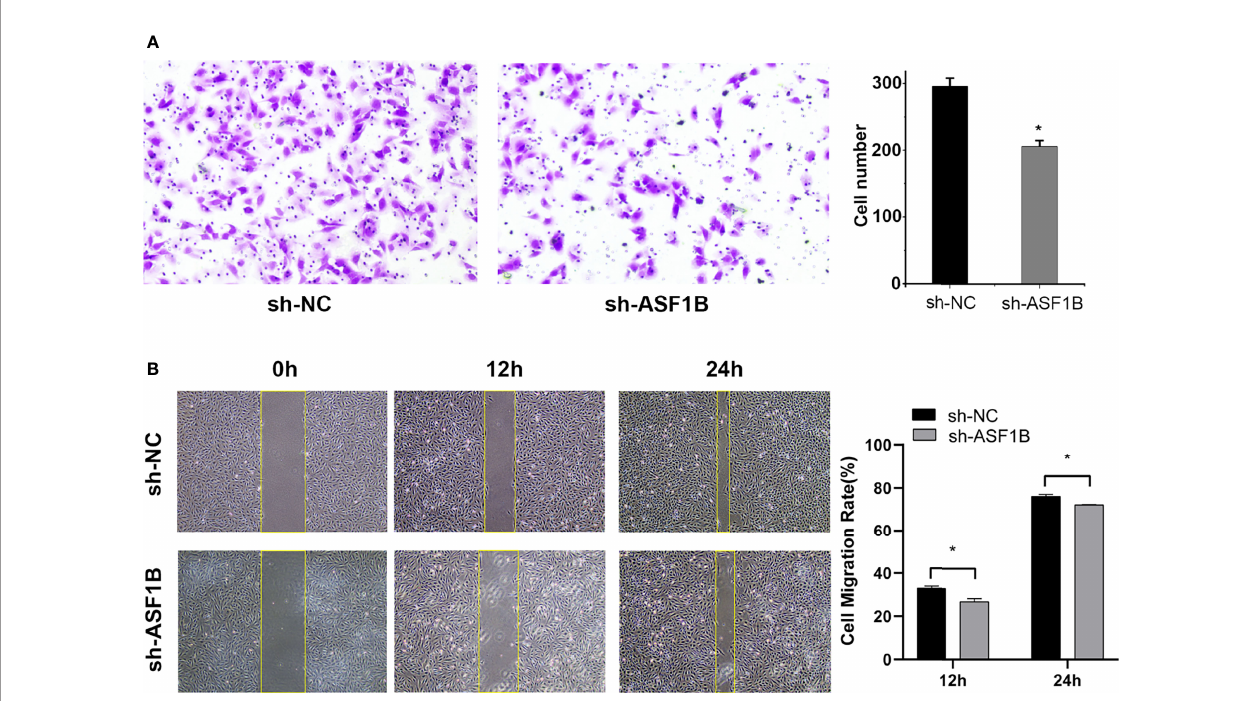
FIGURE 11 | Knockdown of ASF1B inhibits male TC cell metastasis in intro. (A) Cell invasiveness was determined by Transwell assay in KTC-1 cells after transfection with sh-NC or sh-ASF1B, *P < 0.05. (B) Cell migration activity was performed by wound healing assay in KTC-1 cells after transfection with sh-NC or ASF1B, *P <